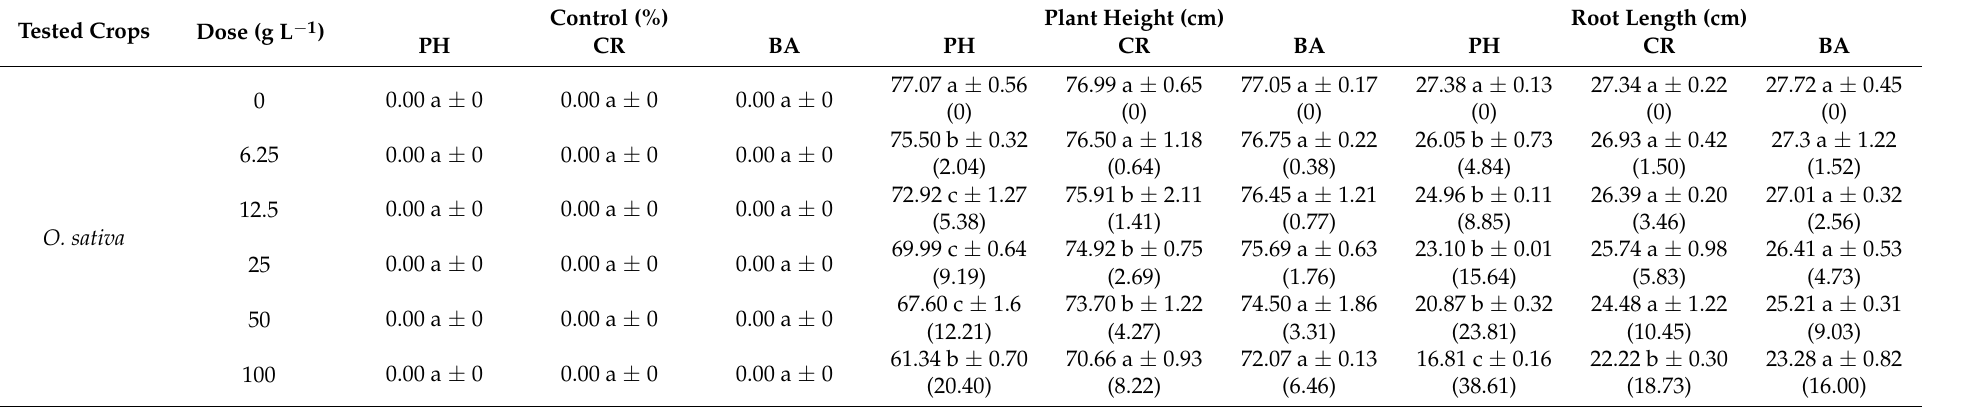
Table 6. Effect of methanol extract of P. hysterophorus , C. rutidosperma , and B. alata on the control (%), plant height (cm), and root length (cm) of O. sativa , Z. mays , A. esculentus , and A. gangeticus